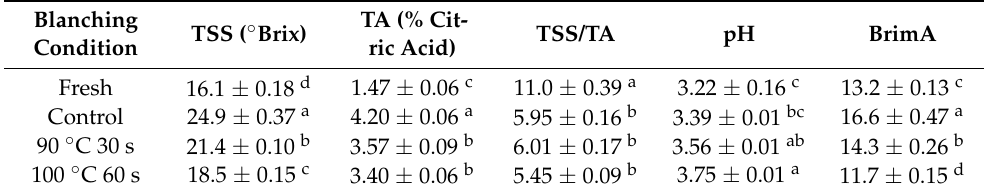
Table 3. Chemical attributes of fresh and dried pomegranate arils with different blanching conditions.